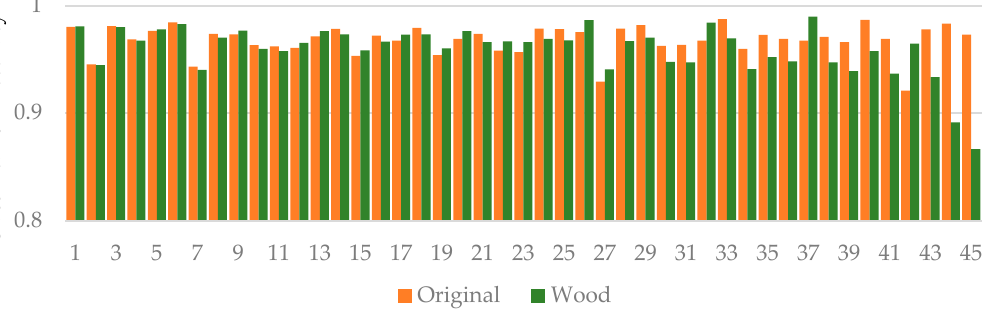
Figure 5. The classification accuracy of tree species corresponds to the experiments before and after the separation of leaf and wood.